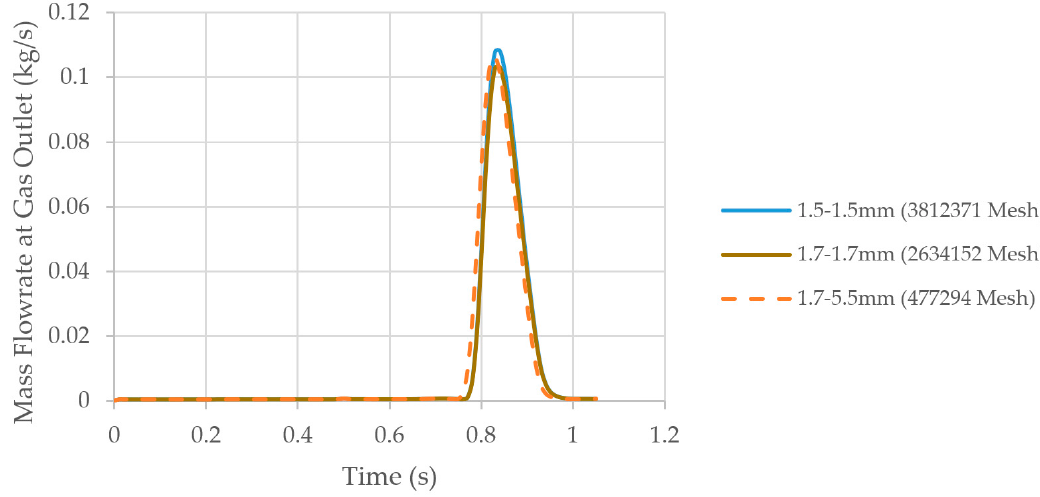
Figure 8. Comparison of selected improved mesh sizes and single meshes of 1.5 and 1.7 mm.